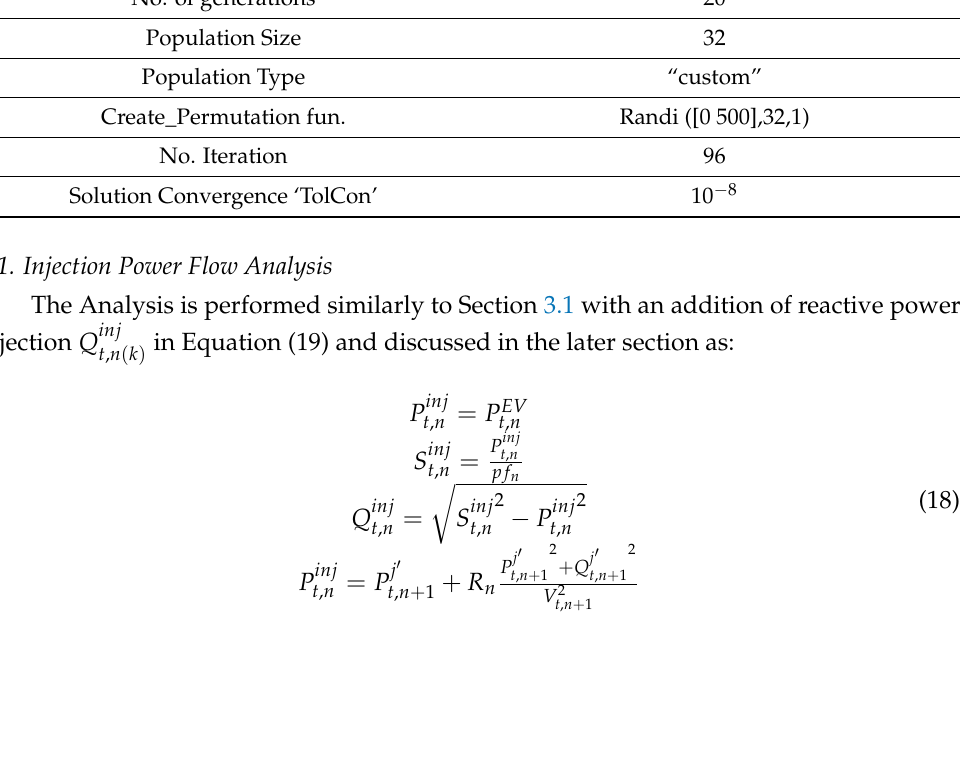
Table 2. Mixed Integer Genetic Algorithm Parameters. No. of